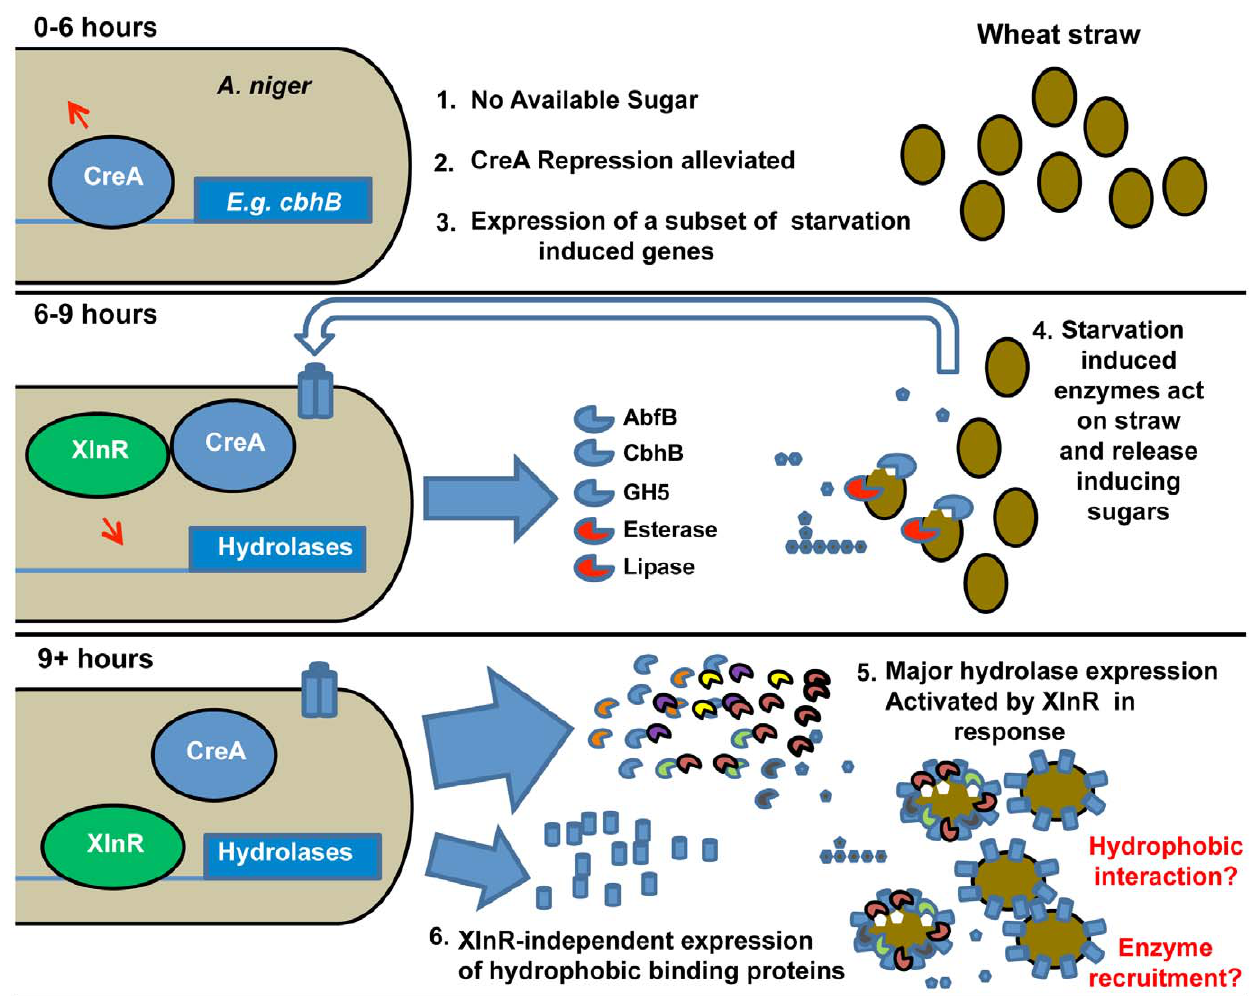
Figure 3. Induction model based on the sequential expression of responsive genes. The sequence of events is illustrated and key events are numbered. The upper panel represents the transcriptional events in A. niger upon exposure (0–6 h) to straw represented by filled ovals. Lack of easily-available carbon source leads to the alleviation of CreA repression (represented by the arrow above CreA) and induction of a subset of starvation-induced genes represented by cbhB . At 6–9 h exposure to straw (middle panel), the expressed hydrolases and other enzymes (examples named in the Figure.) act upon the wheat straw, releasing small quantities of inducing sugars such as xylose (filled pentamer) as well as glucose (filled hexamer). Transporters for the sugars are induced (indicated by the trans-membrane cylinders and un-filled large arrow). By 9 hours (lower panel) the presence of xylose has caused activation of XlnR and, thereby, large scale expression of hydrolases genes. Also induced by 9 hours, in an XlnR- independent manner, is the hydrophobic binding protein HsbA. The hydrophobin HfbD is induced by 12 hours. A physical association of hydrophobic binding proteins with straw and degradative enzymes is hypothesised and represented. Note that the functionality of XlnR and CreA is indicated by attachment to recognition sequences in target promoters and is meant only to indicate the functional control of those promoters by the transcription factors. Modifications to those transcription factors (e.g. phosphorylation of XlnR in A. oryzae [65]) may occur without necessarily implying that their location